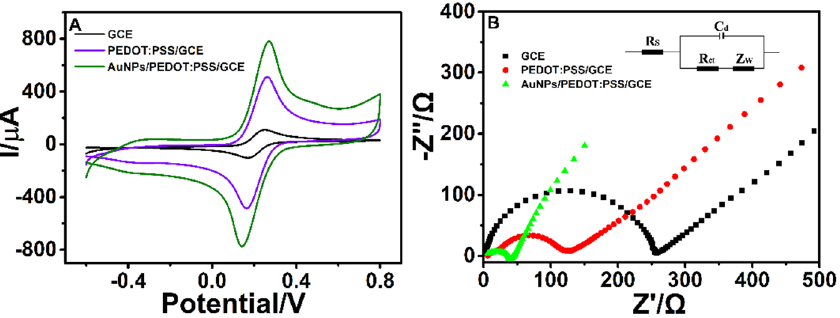
Figure 2. CV ( A ) and EIS ( B ) of the bare GCE, PEDOT:PSS-modified GCE, and AuNP/PEDOT:PSS- modified GCE. Inset of B: Randles equivalent circuit.